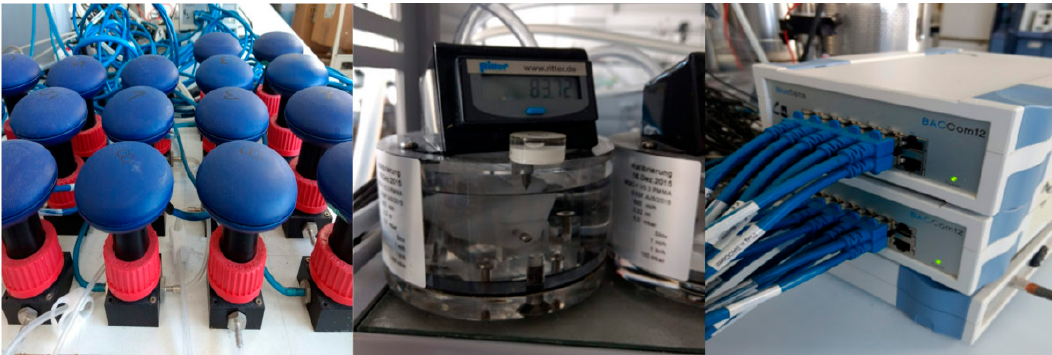
Figure 1. Equipment used for the biogas measurement and characterization. From left to right—infrared on-line sensors, the MilliGas counter, and the data interface module.